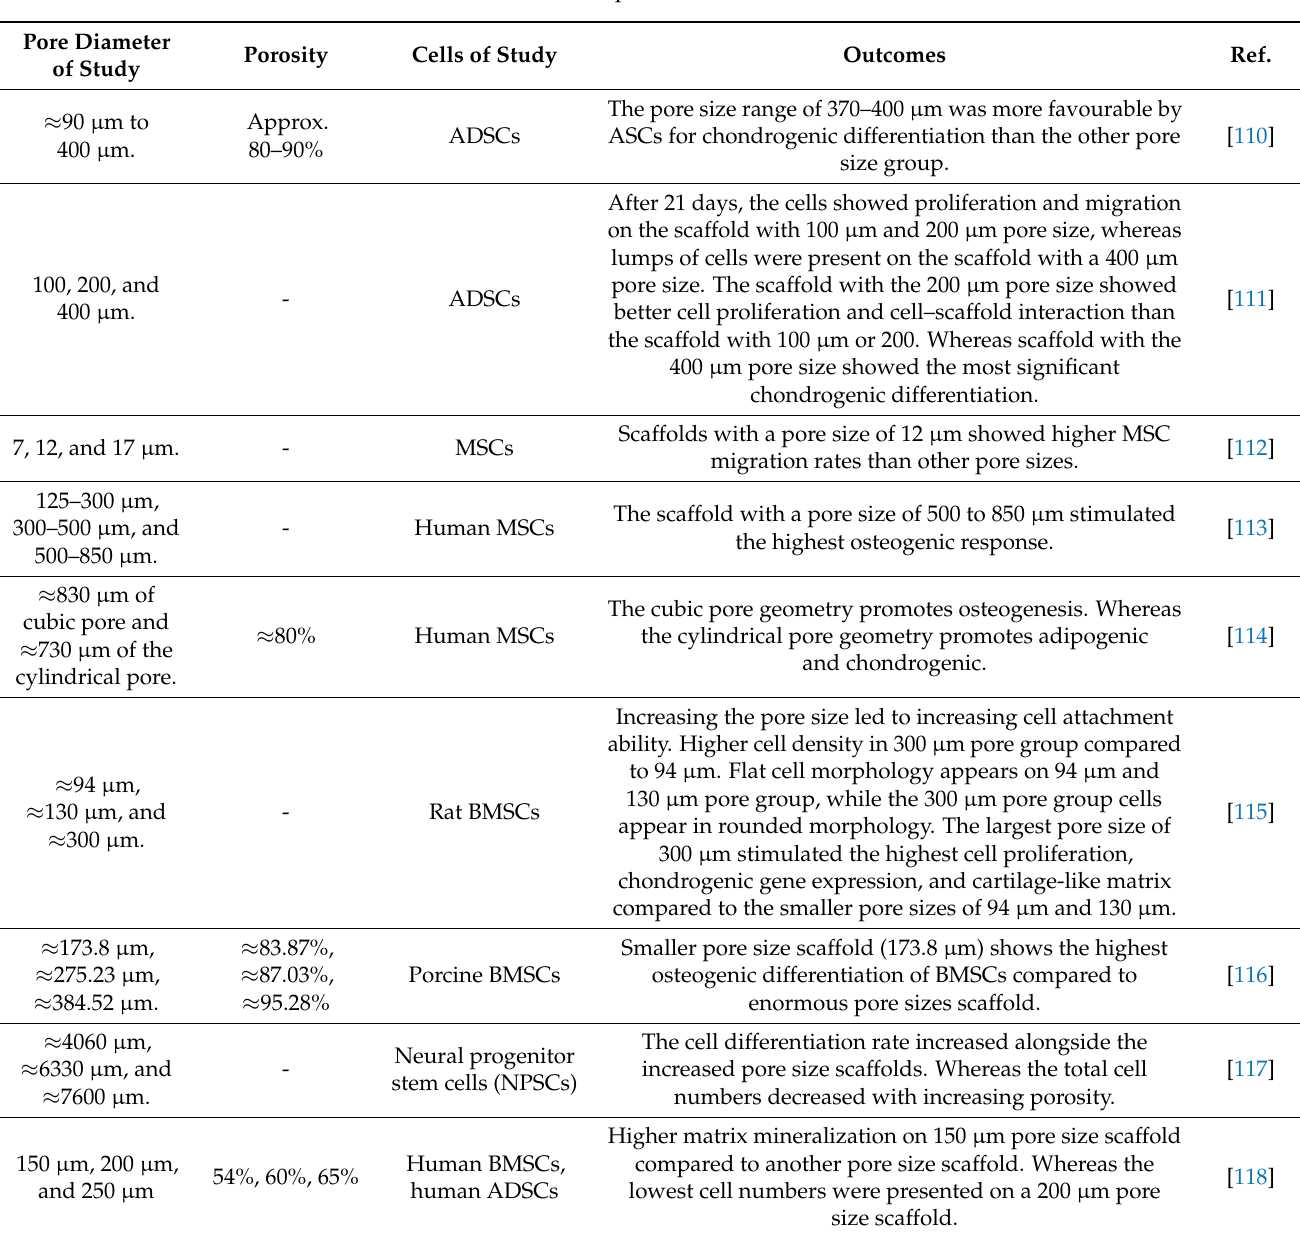
Table 5. The effect of pore size on SCs